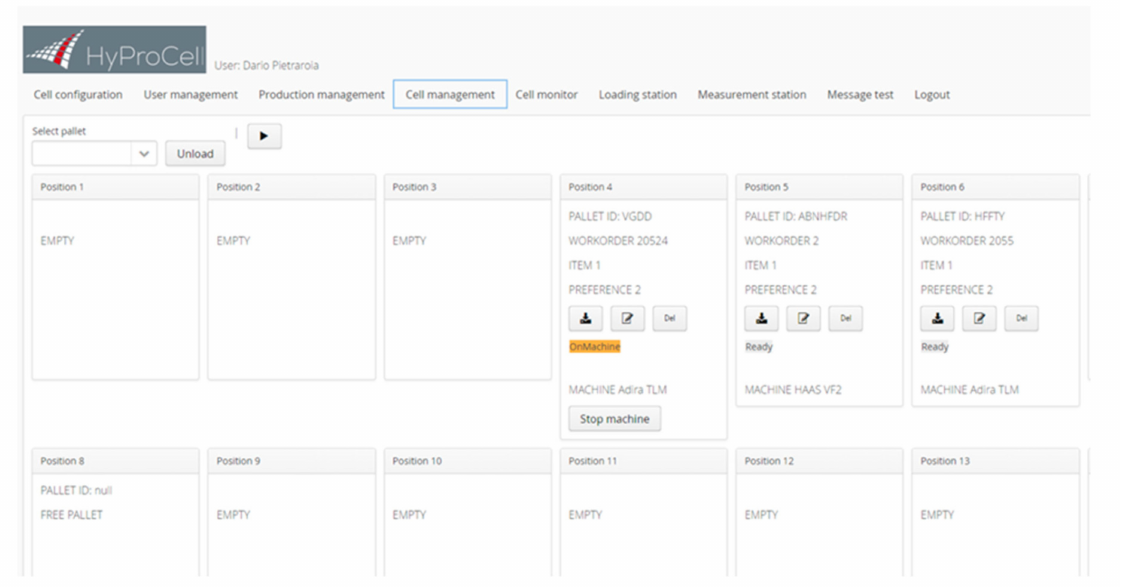
Figure 11. Screenshot capture of the Cell management interface of the MES running in the SLM Pilot Cell at